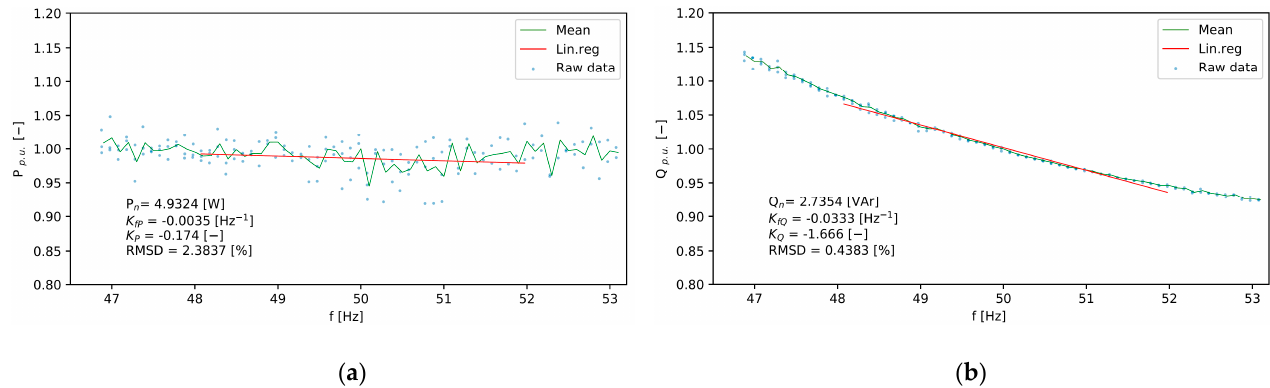
Figure 4. Example of the analyzed result of static load characteristic of ( a ) vacuum cleaner (800 W); ( b ) and heat gun (2000 W) operated at half power .